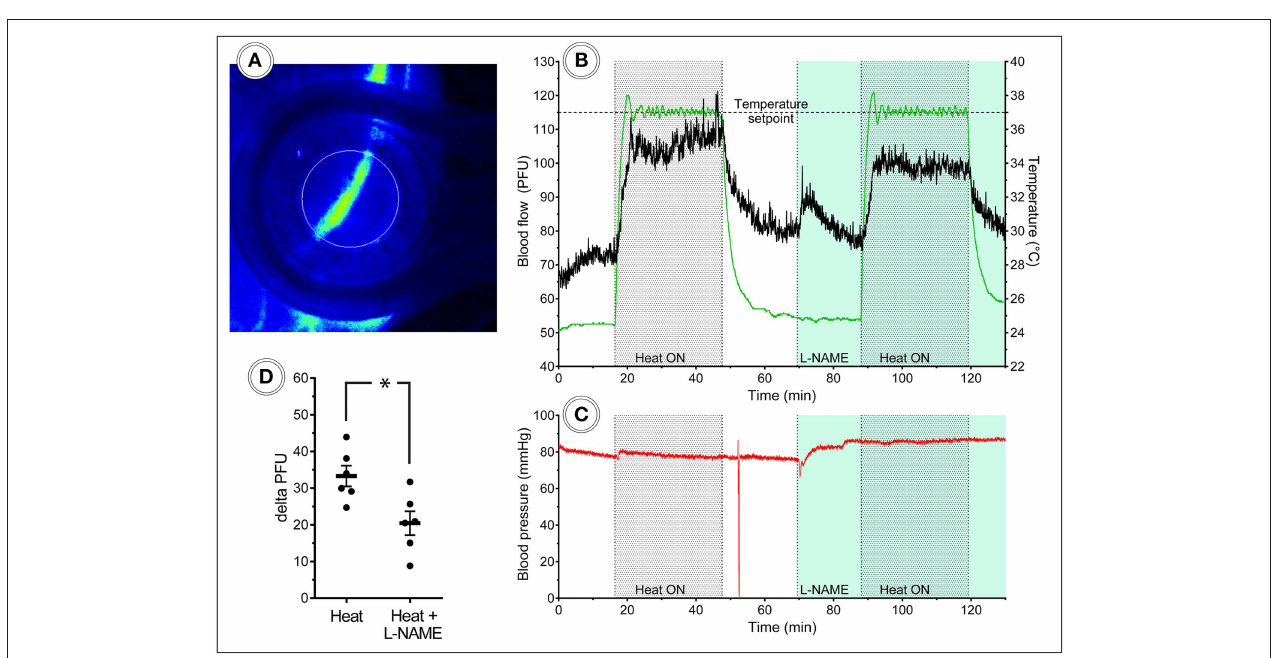
FIGURE 7 | Laser speckle blood flow imaging in the mouse hind limb. (A) Laser speckle contrast image of a mouse hind limb with heat turned off, (B) 130min continuous blood flow and (C) arterial blood pressure measurements, including two heat challenges and L-NAME administration, (D) heat-induced hyperemia is attenuated after L-NAME administration ( n =